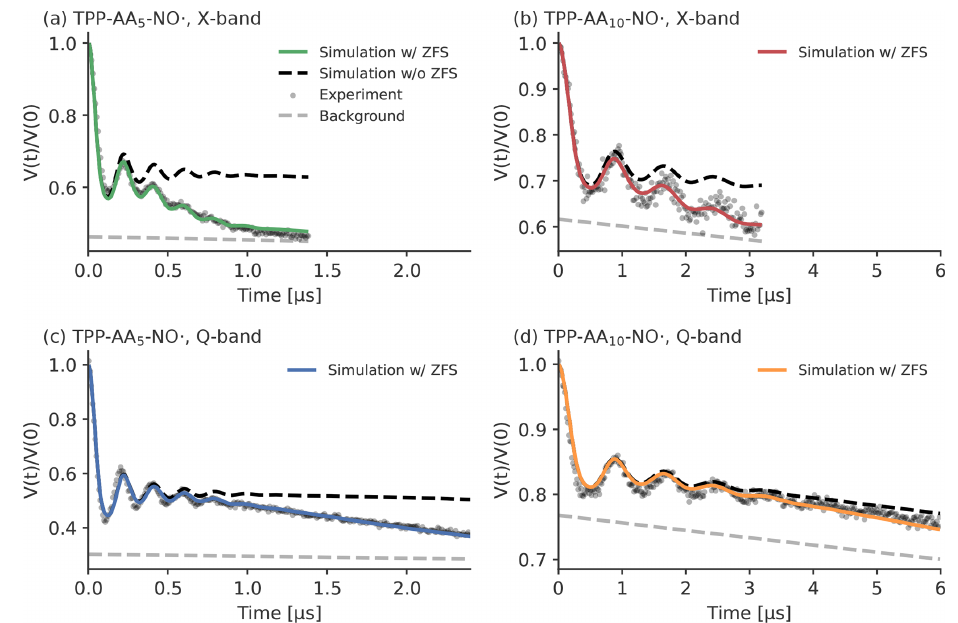
(cid:113) (cid:113) (cid:113) in X-band ( ν T = 9 . 31GHz) (red), panel (c) shows TPP–AA 5 –NO (cid:113) in Q-band ( ν T = 34 . 00GHz) (orange). The colored traces show